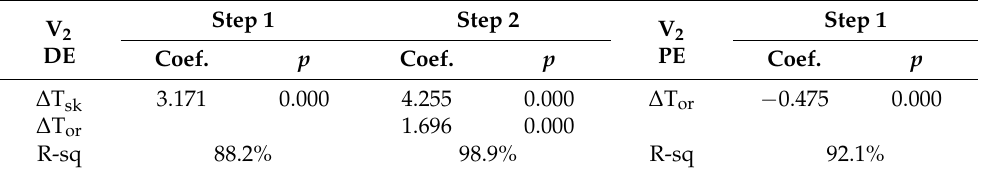
Table 6. Stepwise analysis of objective indicators and TSV.